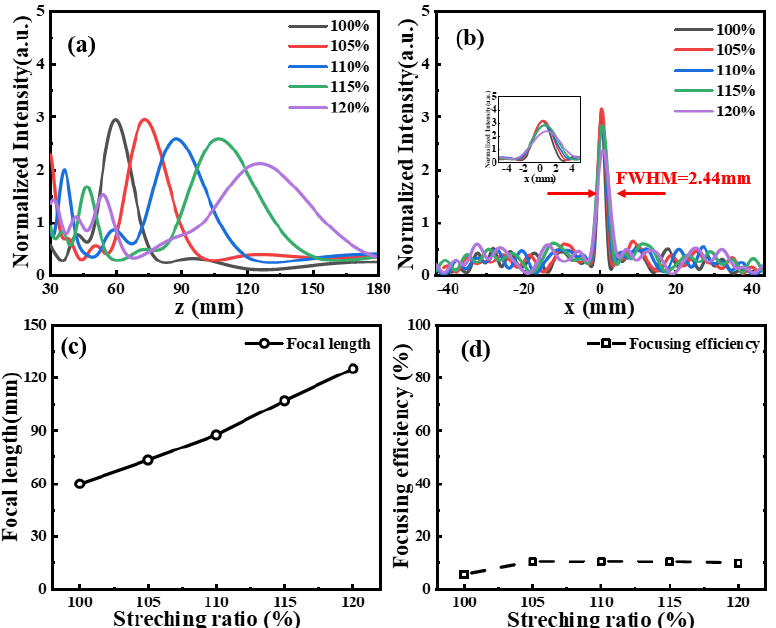
Figure 6. Dynamic focusing performance of single-layer metal C-shaped SRRs at the frequency of 0.1 THz. ( a ) Normalized electric field intensity distribution along the z -axis ( x = 0) when the PDMS substrate is stretched from 100% to 120%; ( b ) normalized electric field intensity distribution in the focal plane when the PDMS substrate is stretched from 100% to 120%; ( c ) the change in the focal length with different stretching factors; ( d ) the change in the focusing efficiency with different stretching